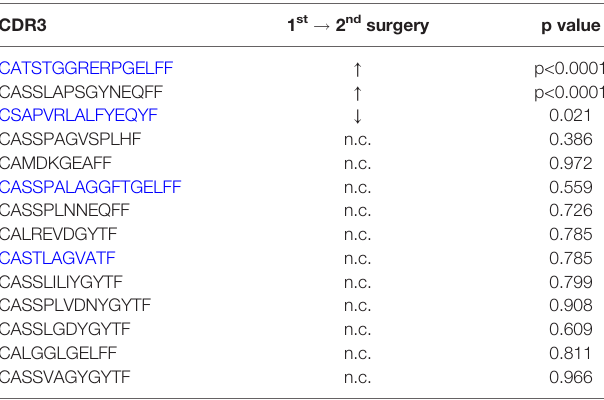
TABLE 5 | Changes in the frequency of T cell clonotypes in brain tissue from the fi rst and second resective surgeries performed on TSC patient 595.